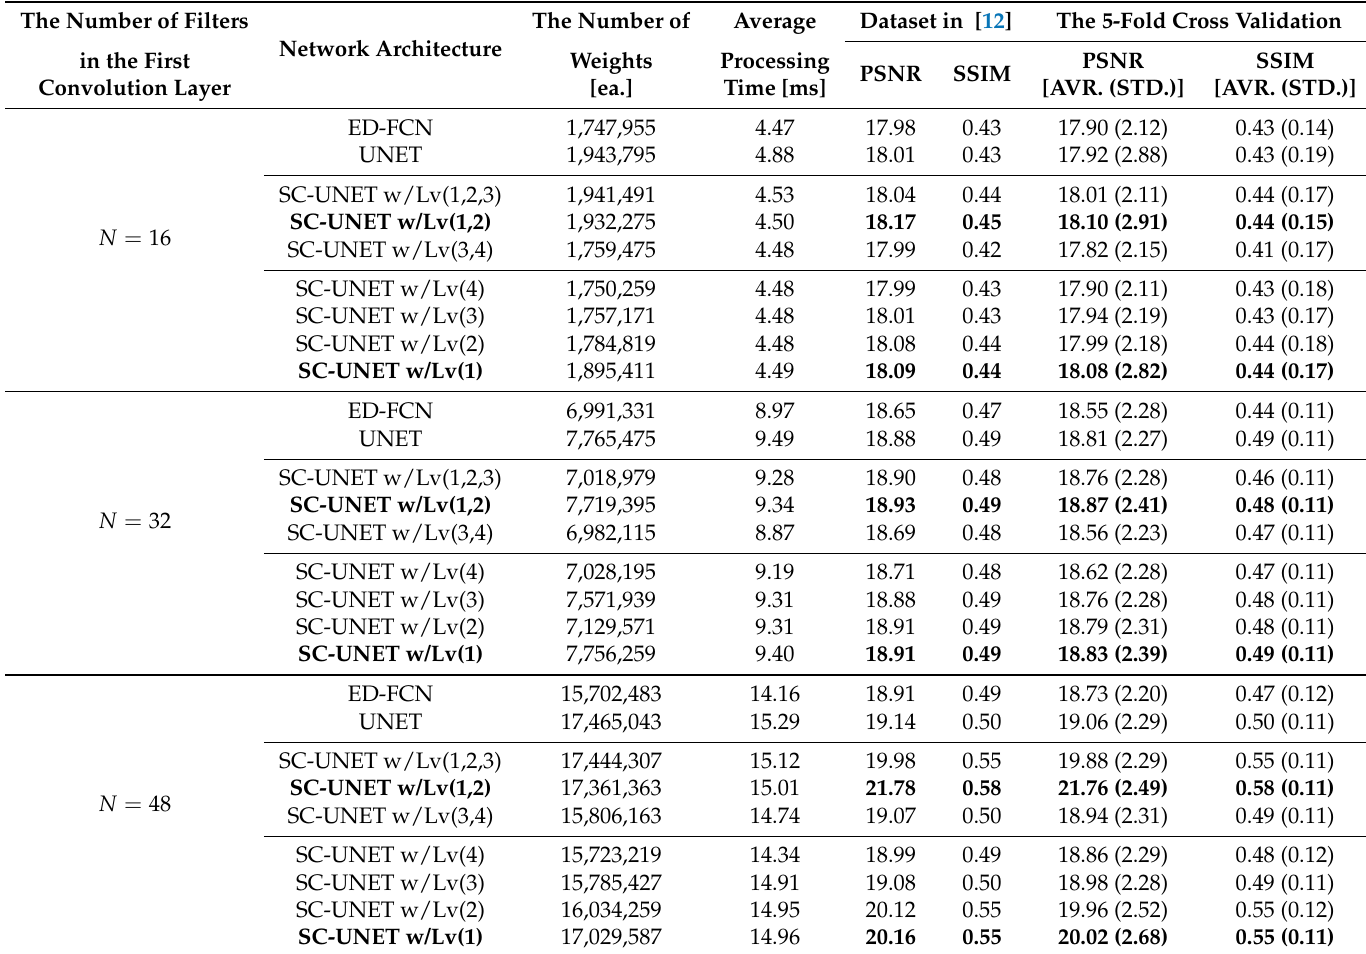
Table 2. Performance results of the proposed SC-UNET-based